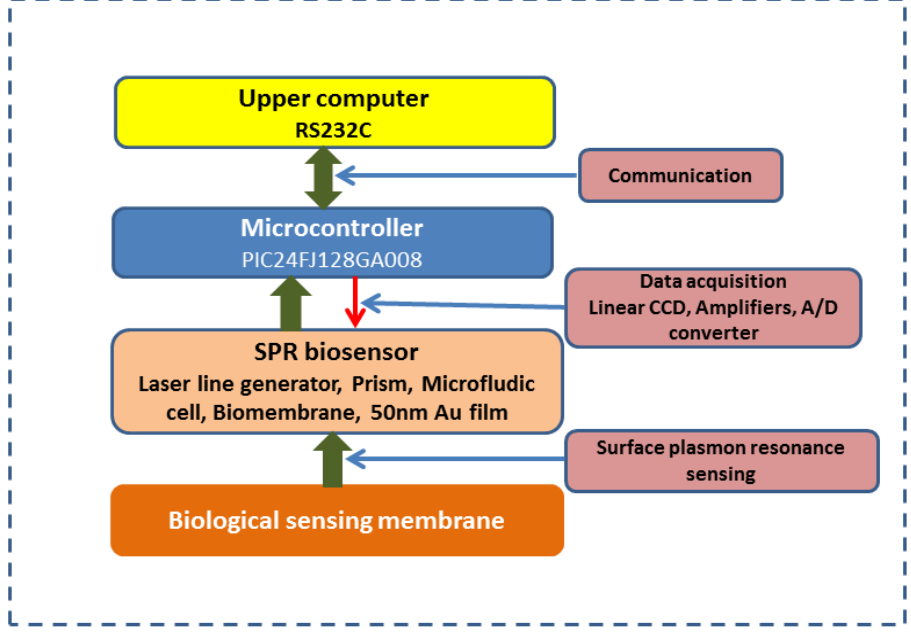
Figure 2. Schematic diagram of the interface system of this SPR biosensing system involving the SPR biosensor, the microcontroller and upper